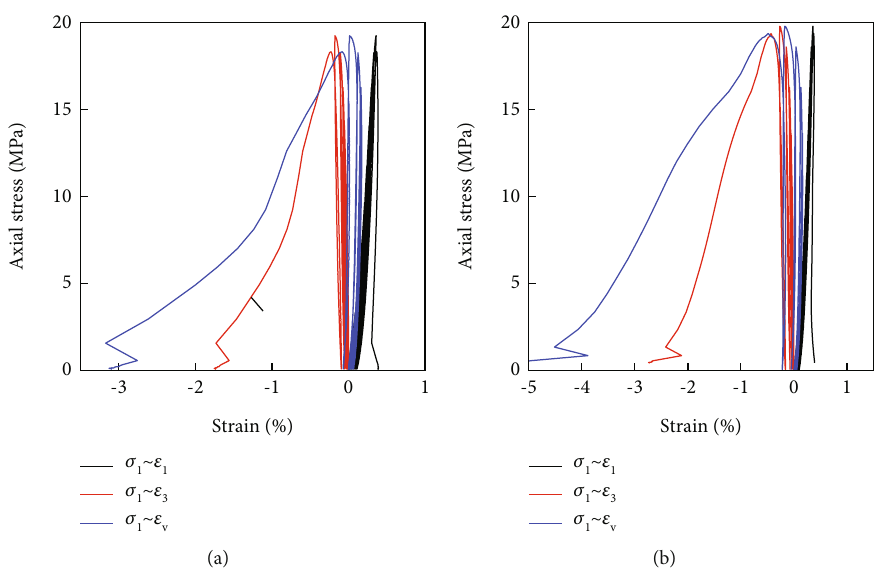
Figure 1: Complete stress-strain curves of sandstone under cyclic loading: (a) UC-C-1; (b) UC-C-2.